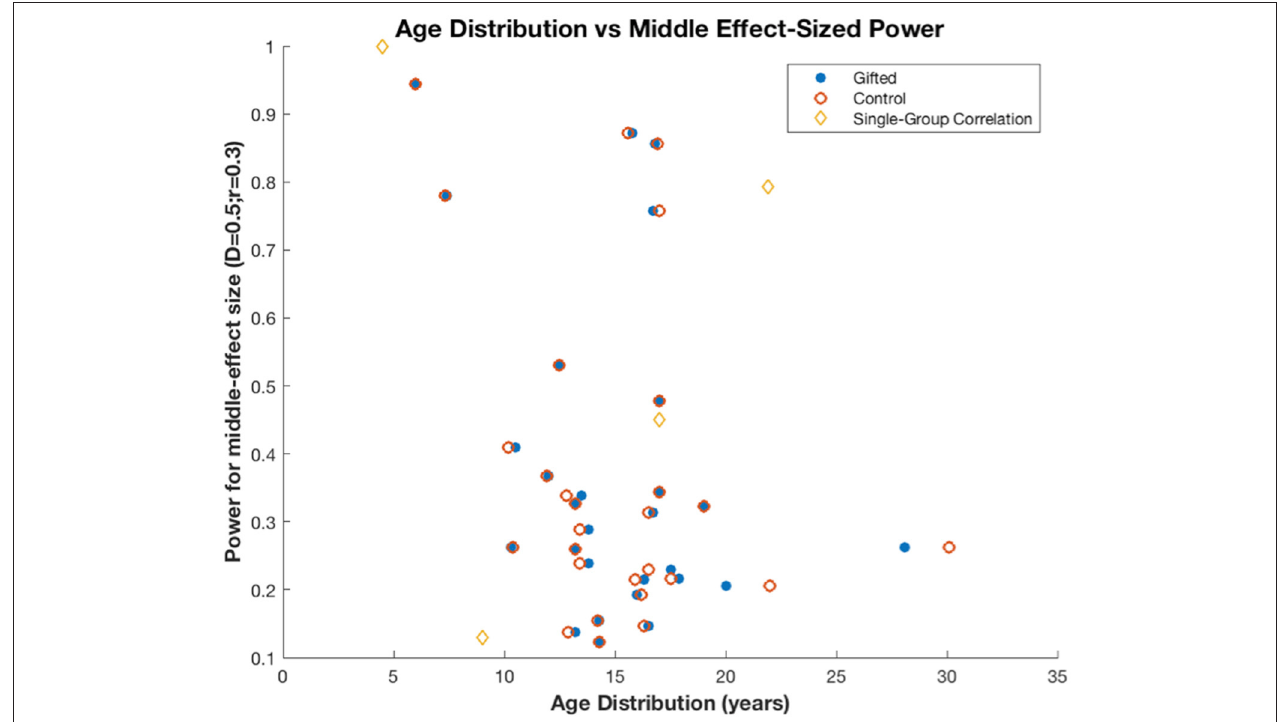
FIGURE 1 | Power to detect medium sized effects in studies with various age groups (D = 0.5 for studies with math gifted and control groups; r = 0.3 for studies finding correlations with one group). Power does not change with age group. Power was relatively high in only eight out of 28 studies and was outstandingly high in a study with very large sample size ( Robinson et al., 1996; N =